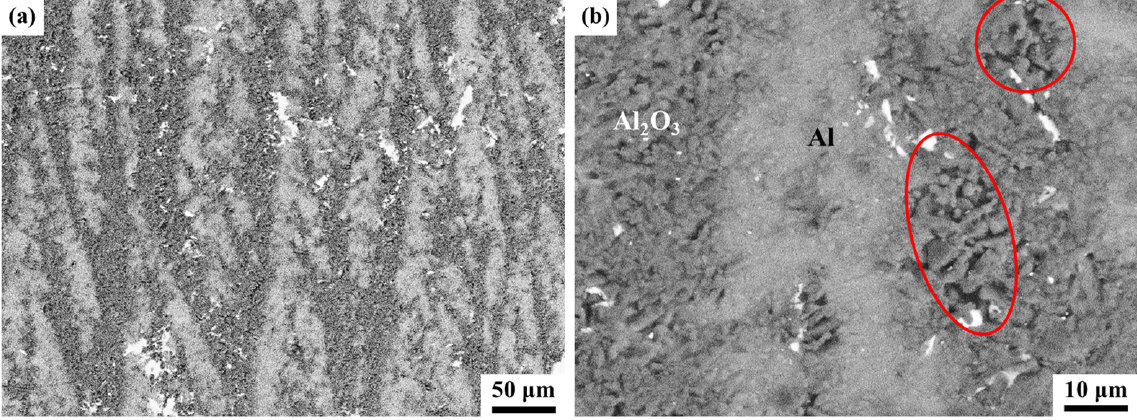
Figure 4: Representative microstructure of the lamellar Al 2 O 3 p/Al composite. (a) Low magnification image, (b) High magnification